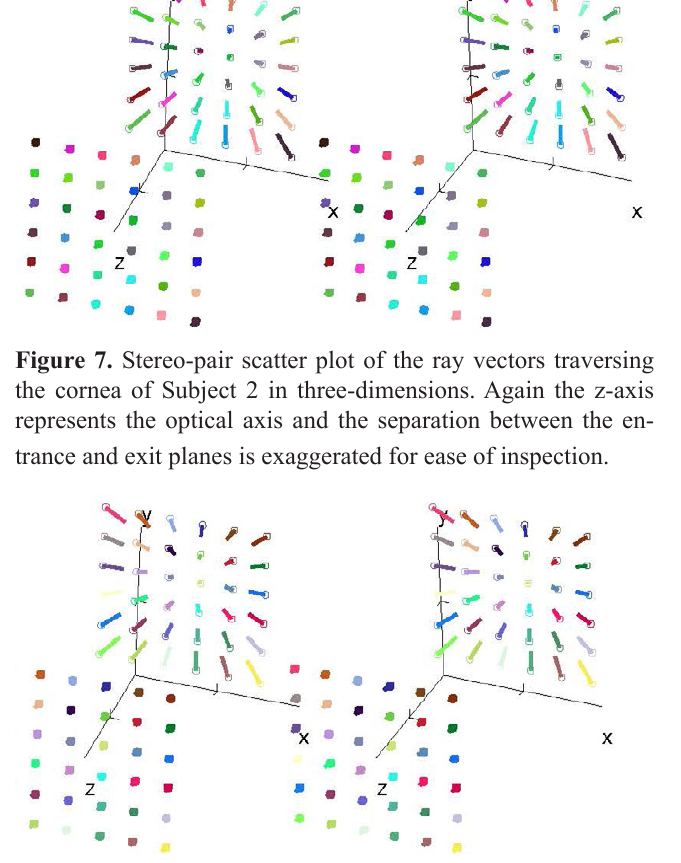
Figure 8. Stereo-pair scatter plot of the ray vectors traversing the cornea of Subject 3 in three-dimensions.